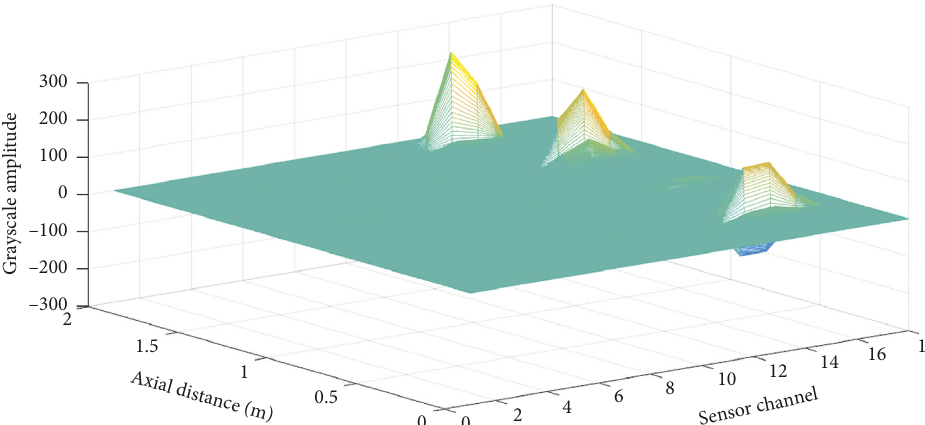
Figure 8: Expanded data after denoising.